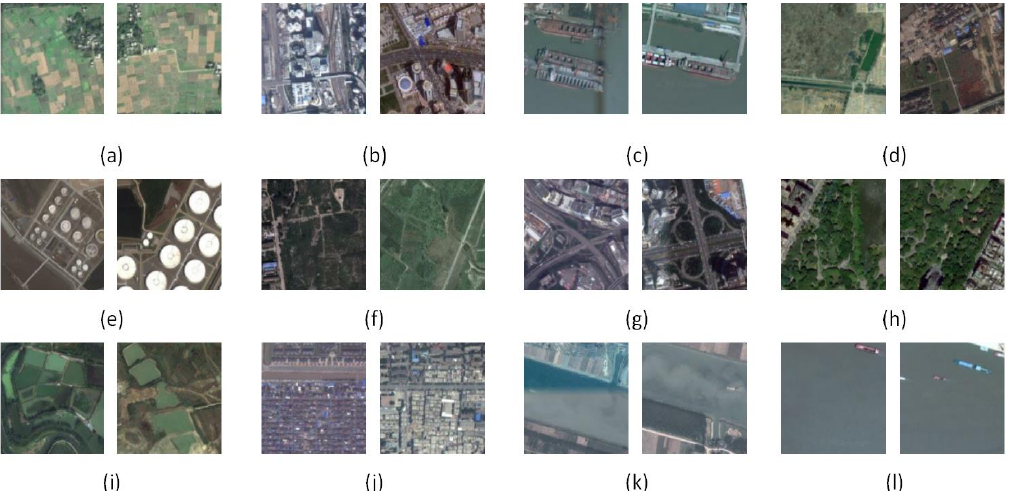
Figure 5. Some example from the SIRI-WHU dataset: (a)agriculture, (b)commercial, (c)harbor, (d)idle land, (e)industrial, (f)meadow,